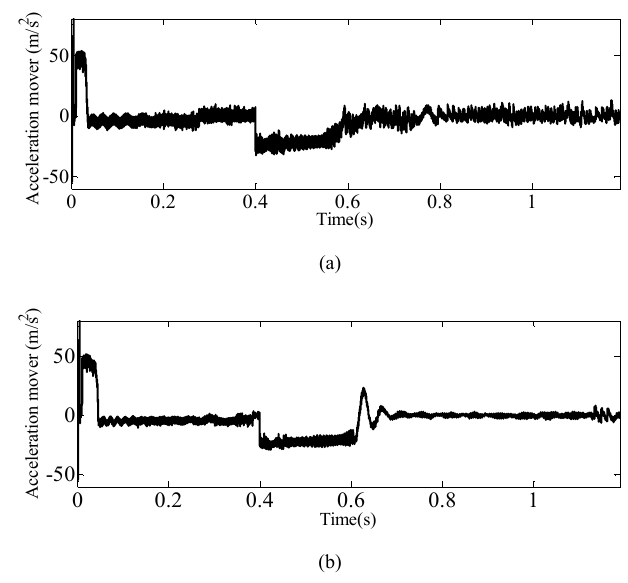
Fig. 6. Acceleration of the mover (a) by using a conventional sliding mode observer (b) by using the proposed sliding mode